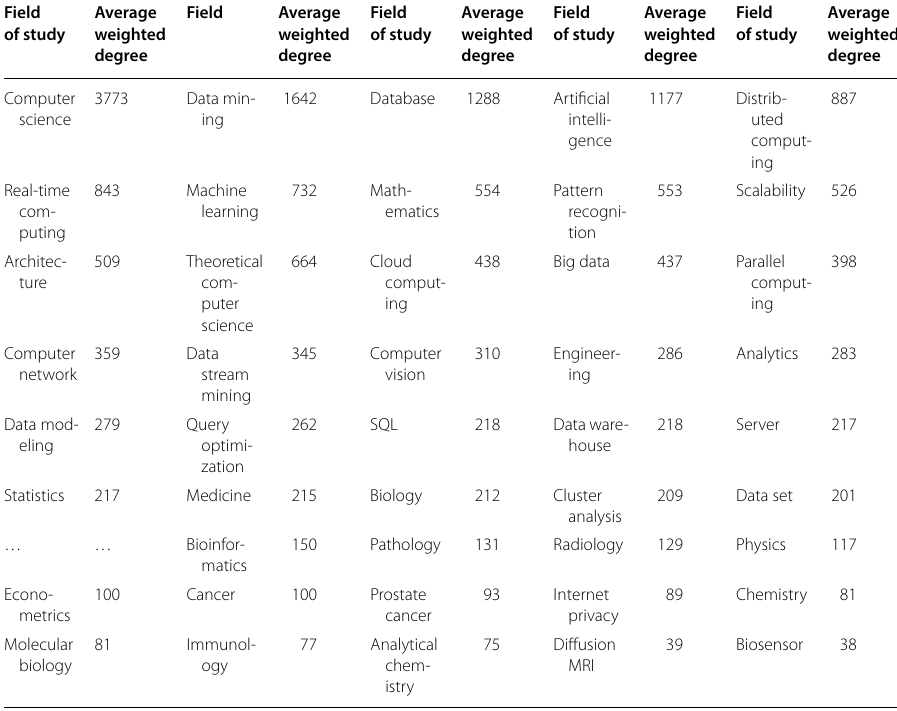
Table 4 Some of fields of studies with the highest weighted degree Field of